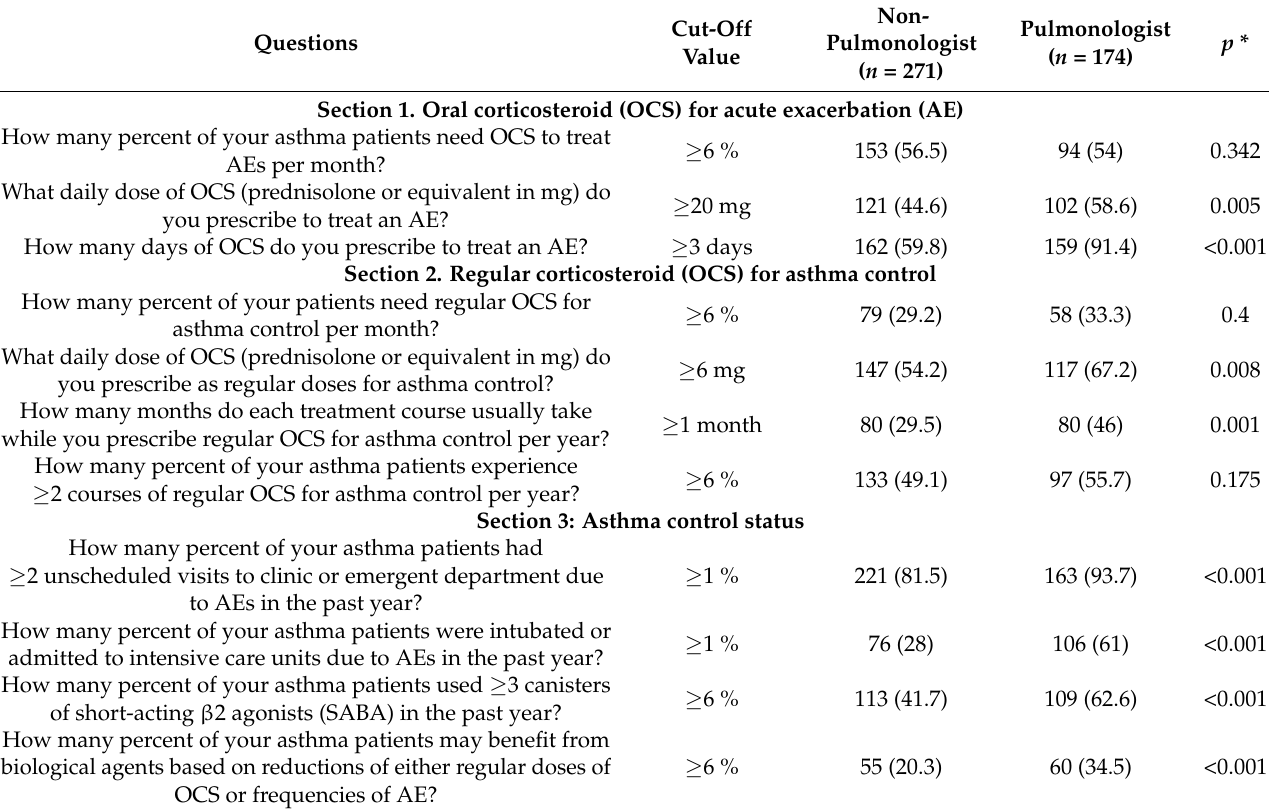
Table 3. Differential responses between pulmonologists and